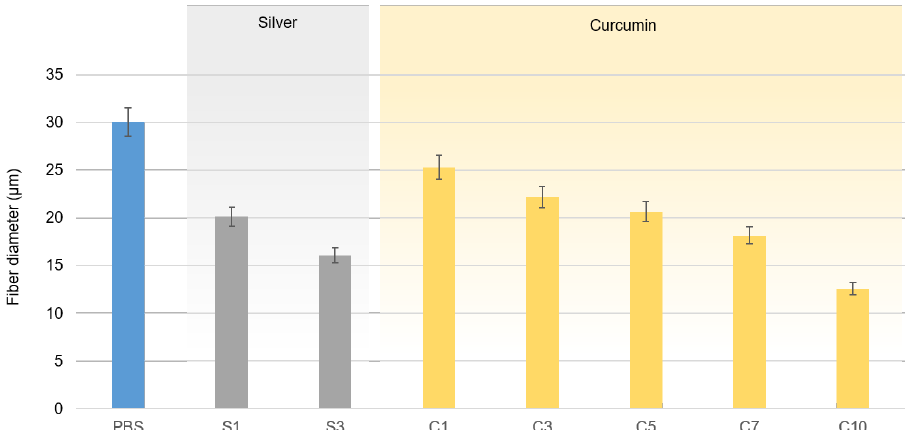
Figure 16. Diameter of PBS and PBS compound fibers produced by melt-electrospinning using a single-nozzle laboratory device at 235 °C and 60 kV, with a nozzle-to-collector distance of 10 cm. Data are means ± standard deviations ( n = 100).